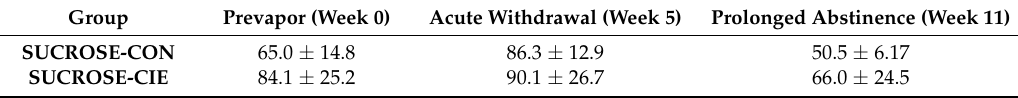
Table 4. Locomotor activity (in meters) did not differ between CIE and control